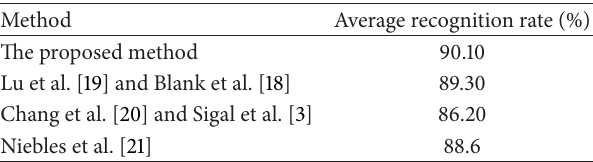
Table 2: Compared with other approaches on Weizmann dataset. Method